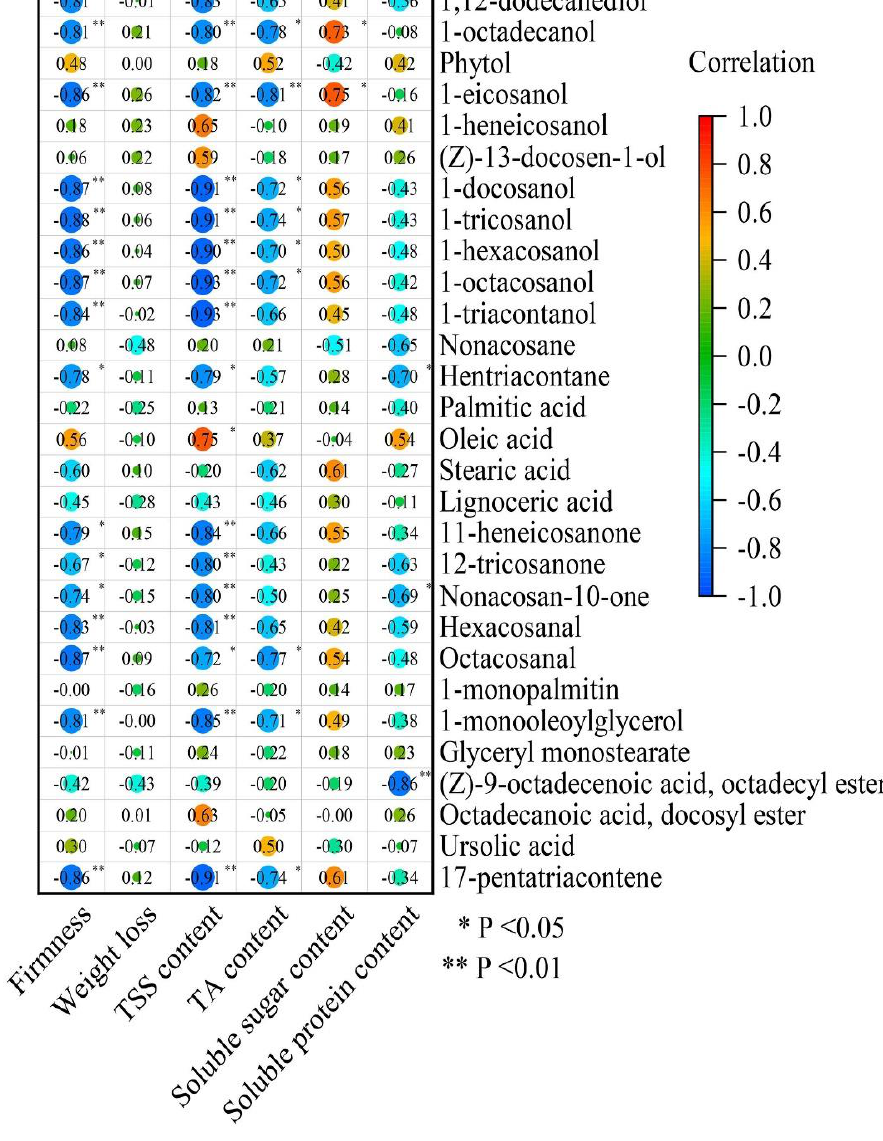
Figure 7. Correlation analysis between wax common constituent and fruit quality among three plum cultivars during storage at room temperature. Note: the Pearson correlation coefficient is expressed by the size of the circle. Blue color indicates negative correlation, and red color indicates positive correlation. * represents significant difference ( p < 0.05), and ** represents extremely significant difference ( p < 0.01).